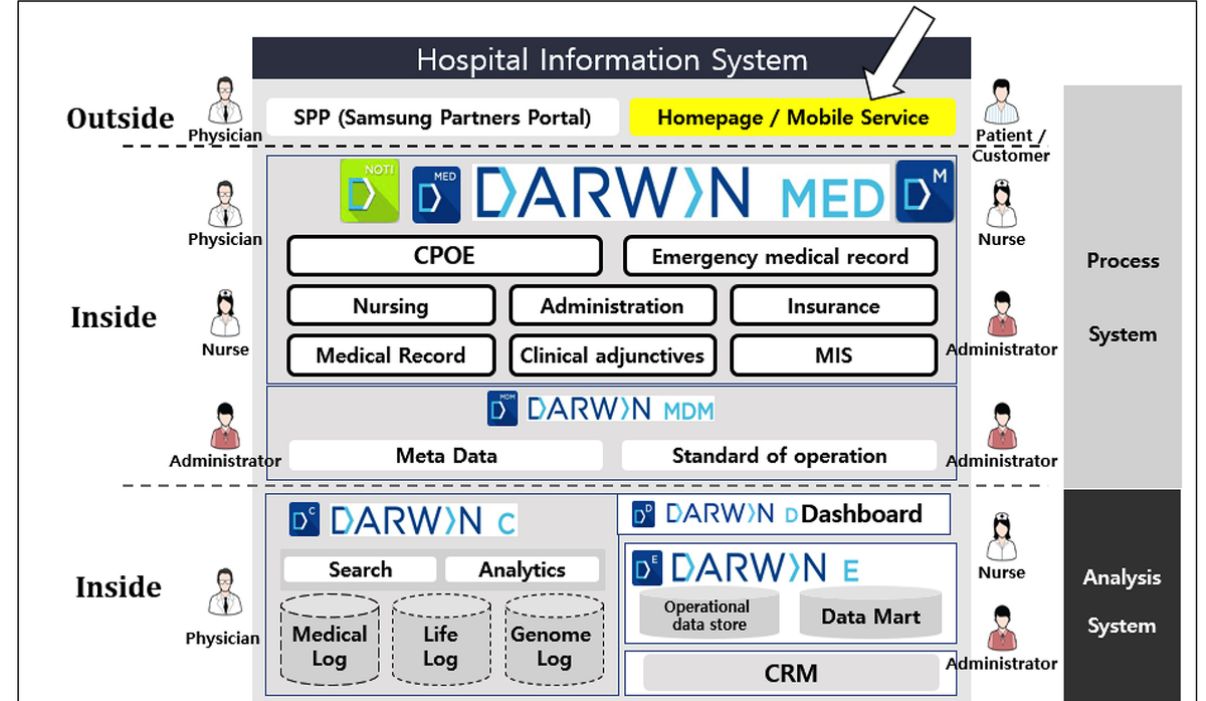
Figure 1. Overall schematic description of the hospital information system architecture at the Samsung Medical Center. DARWIN: Data Analytics and Research Window for Integrated Knowledge; CPOE: computerized physician order entry; MIS: management information system; MDM: master data management; CRM: customer relationship management. Reproduced with permission from Jung et al